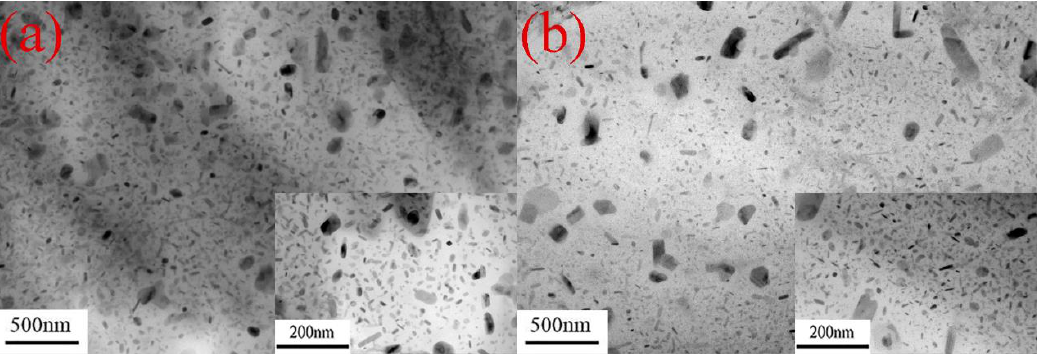
Figure 6. Transmission electron microscopy (TEM) micrograph of 7075 Al alloy after ageing treatment, ( a ) CST475-30 + AA, ( b ) CST535-10 + AA.